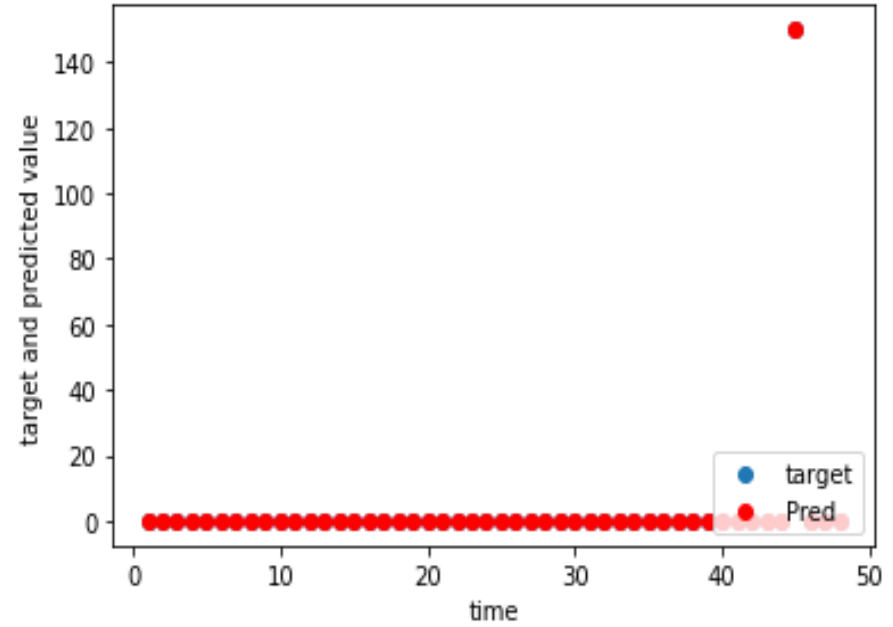
Figure 11. Charging demand prediction of a weekday for Munkkiranta.